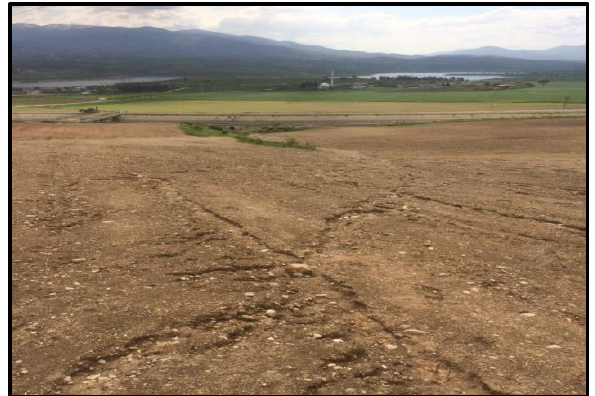
Figure 1. Descriptive field image and occurrence of ephemeral gully erosion in study area dated at